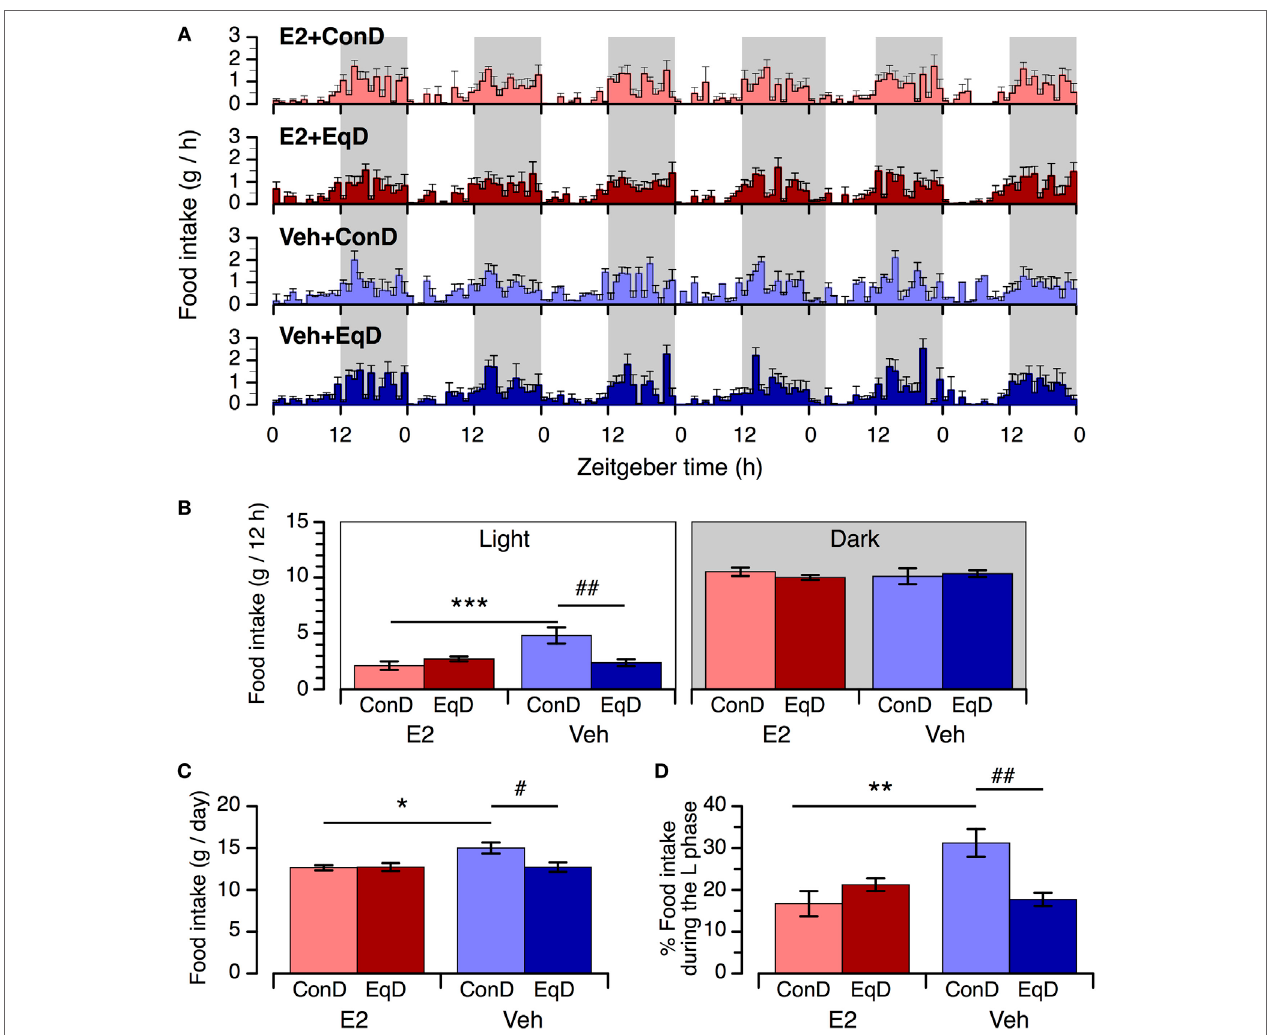
FigUre 2 | The effect of estradiol (E2) replacement and dietary S -equol on circadian feeding patterns (a) , food intake during the light phase [ (b) , left] and dark phase [ (b) , right], daily food intake (c) , and percentage of daily food intake that occurred during the light phase (D) in ovariectomized rats. Rats were ovariectomized and assigned to the E2-replaced or cholesterol [vehicle (Veh)]-treated group. These rats were fed a standard (control) diet (ConD) or an S -equol-containing diet (EqD) Values are shown as the mean ± SEM ( n = 6 in each group). Shading in A depicts the 12-h dark phase. *, **, and ***, significant differences ( P < 0.05, P < 0.01, and P < 0.001, respectively) between the E2-replaced and Veh-treated groups fed the same diet. # and ## , significant differences ( P < 0.05 and P < 0.01, respectively) between the rats fed ConD and EqD with the same